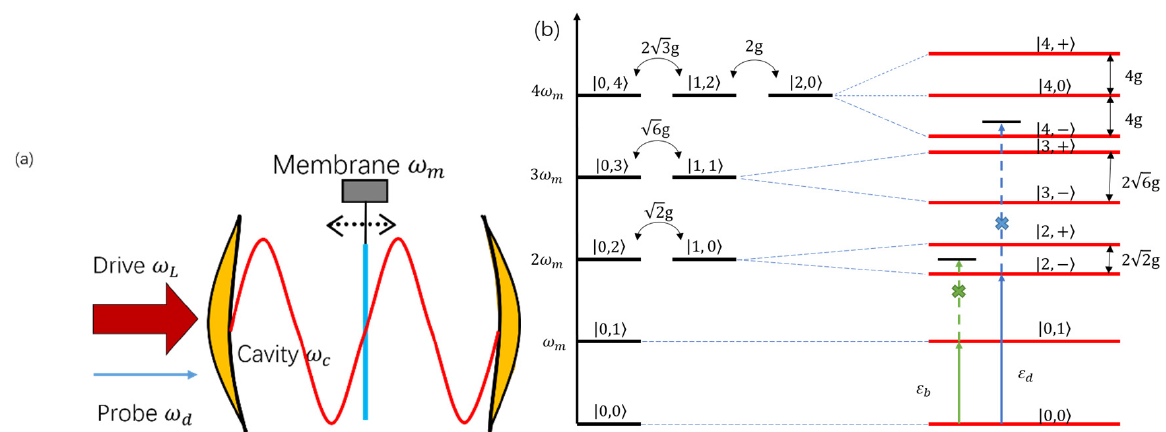
Figure 1. ( a ) Schematic illustration of an optomechanical system consisting of an optical cavity mode (with frequency ω c ) quadratically coupled to the mechanical mode (with frequency ω m ) with the “membrane-in-the-middle” configuration. In addition, the optical cavity is driven by a strong pumping field with frequency ω L and a weak driving field with frequency ω d . ( b ) Energy-level diagram of the quadratically coupled optomechanical system. Here the bare states are labelled by | n , m (cid:105) , where | n (cid:105) and | m (cid:105) denote the eigenstates of the photon number and the phonon number, respectively. The green arrow describes the process of the single-phonon blockade when the mechanical resonator is weakly driven with the driving strength ε b . The blue arrow describes the process of the two-phonon blockade when the optical cavity is weakly driven with the driving strength ε d .